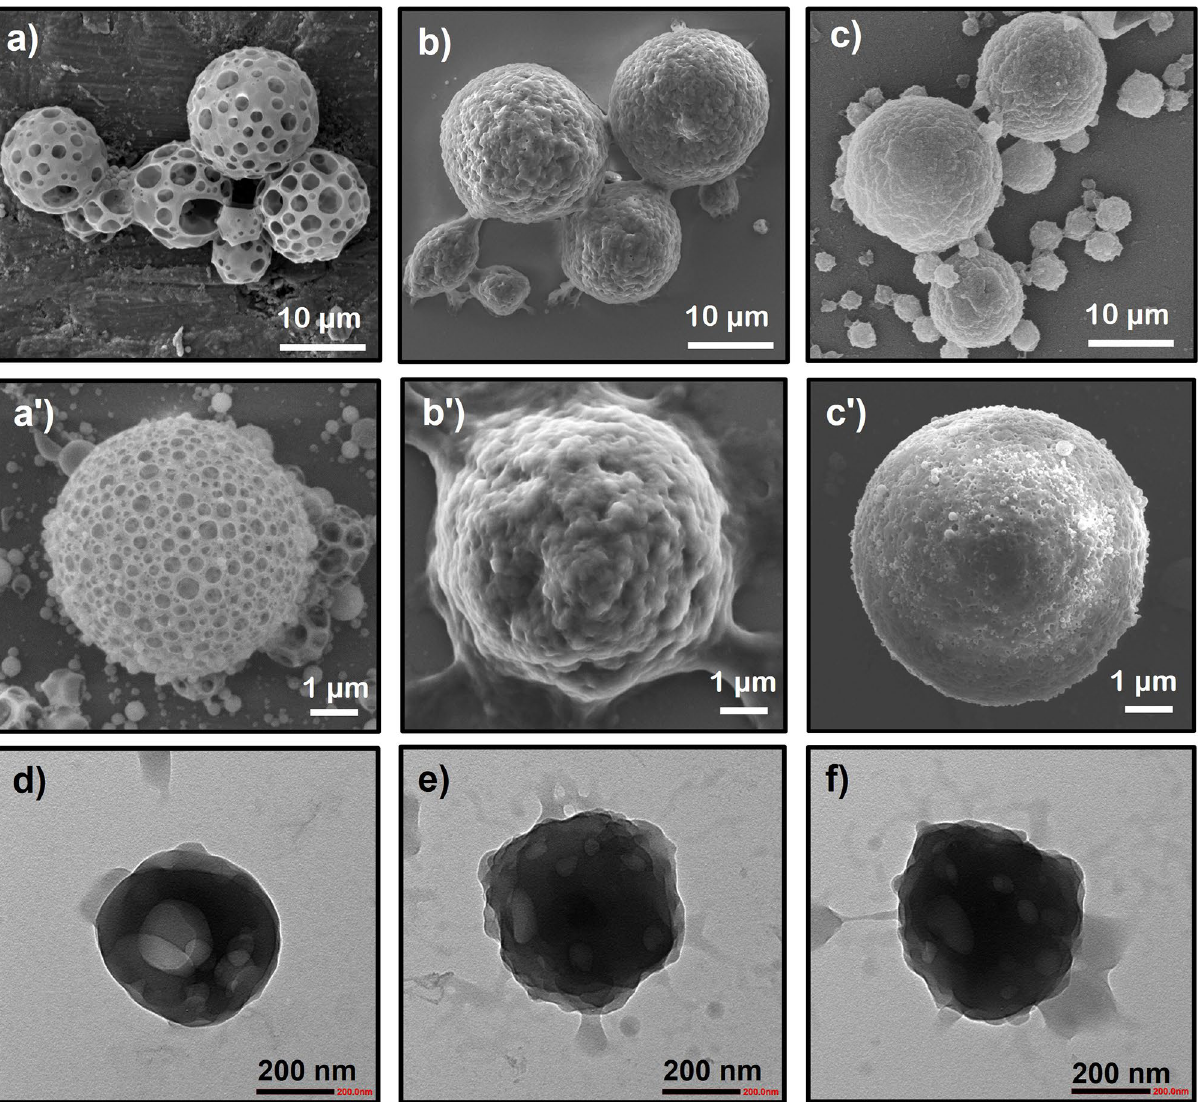
Figure 5. SEM images of Eudragit RS100 porous particles and PNIPAM@RS100 prepared by ultra turrax; ( a , a ′ ) UT-RS100, ( b , b ′ ) UT-APS, ( c , c ′ ) UT-APS/TEMED, and TEM images of nanoparticles prepared by ultrasonication; ( d ) US-RS100, ( e ) US-APS, ( f ) US-APS/TEMED. The images were taken at 5kX ( a – c ), 10kX ( a ′ – c ′ ) and 25kX ( d – f )